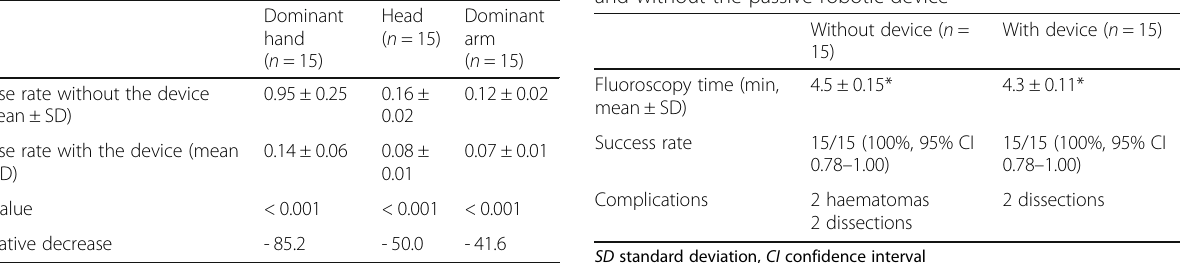
Table 1 Radiation dose rate (mSv/hour) for the operating physician with and without the passive robotic device